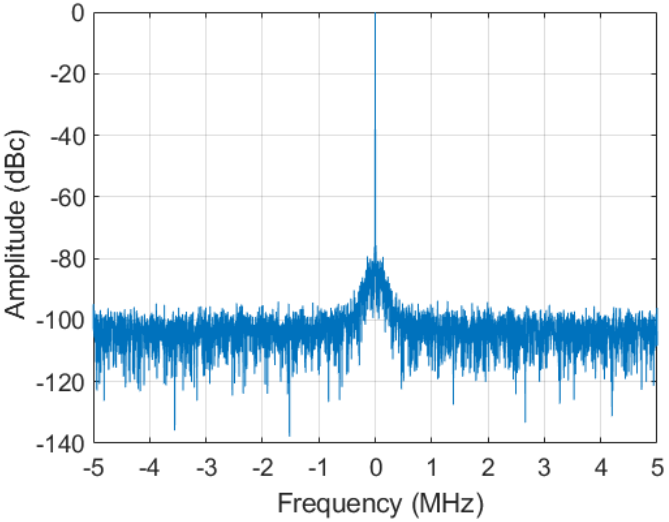
Figure 13. FFT of the demodulated 1.3-GHz input signal in the − 5 MHz to 5 MHz